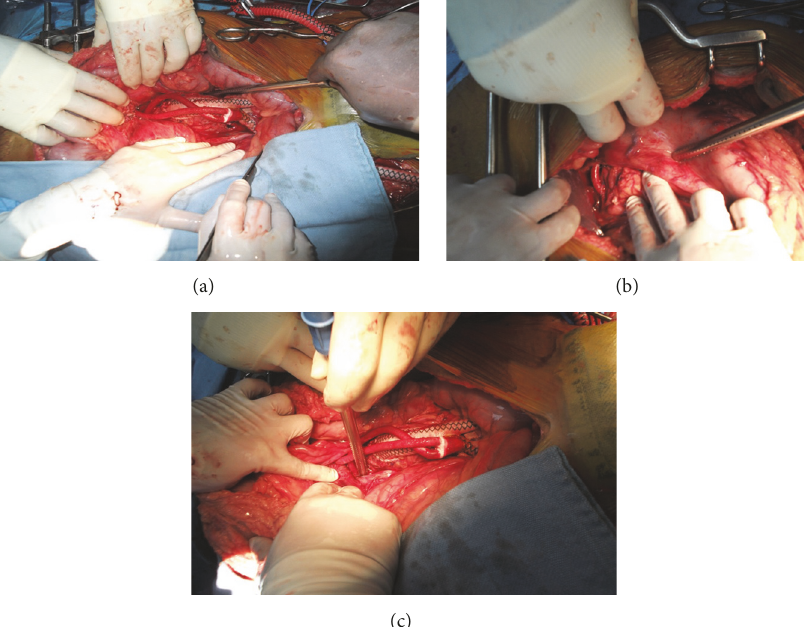
Figure 2: Intraoperative exposure showing the aortobifemoral, aorto-right renal, and aorto-celiac/superior mesenteric artery bypass grafts (a). Anastomosis of the graft to the right renal artery (b). Anastomosis of the graft to the superior mesenteric and celiac arteries